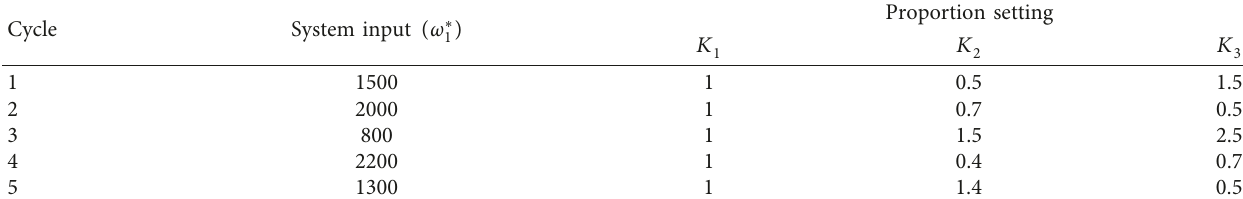
Figure 13: The synchronization error of all servos under SMC. Table 2: System input and proportion